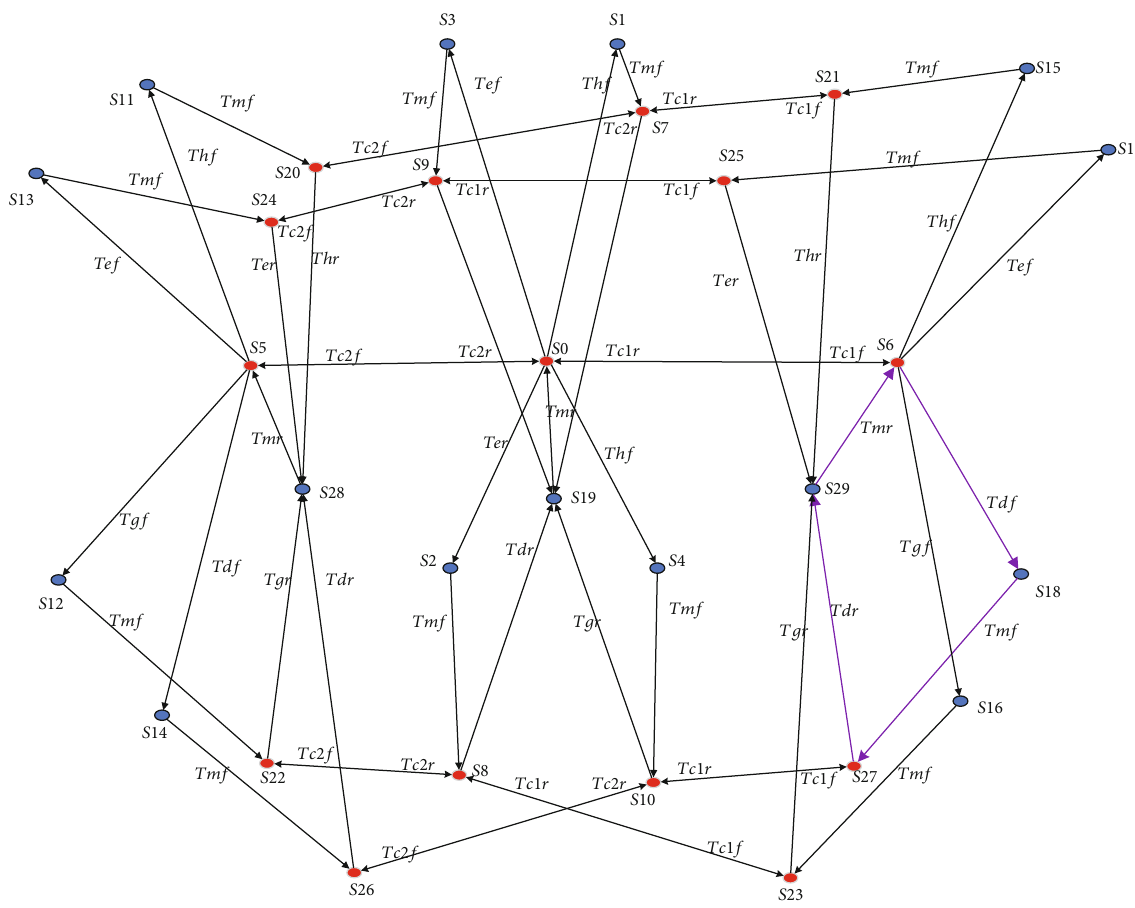
Figure 9: Reachability graph of the FTGPN model for the IMA system.